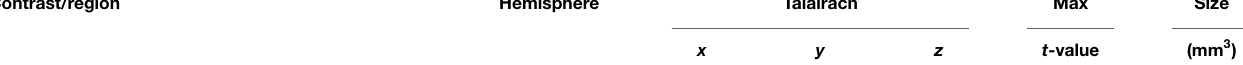
TABLE 3 | Whole brain random effects group analysis; p < 0.001; corrected for multiple comparisons via cluster-size thresholding at 4 voxels (108mm 3 ) . Contrast/region Hemisphere Talairach Max Size x y z t -value (mm 3 ) Contrast analysis: differential effects when contrasting left hand versus right hand finger tapping Right hand > left hand Pre- and postcentral gyrus (primary sensorimotor cortex)